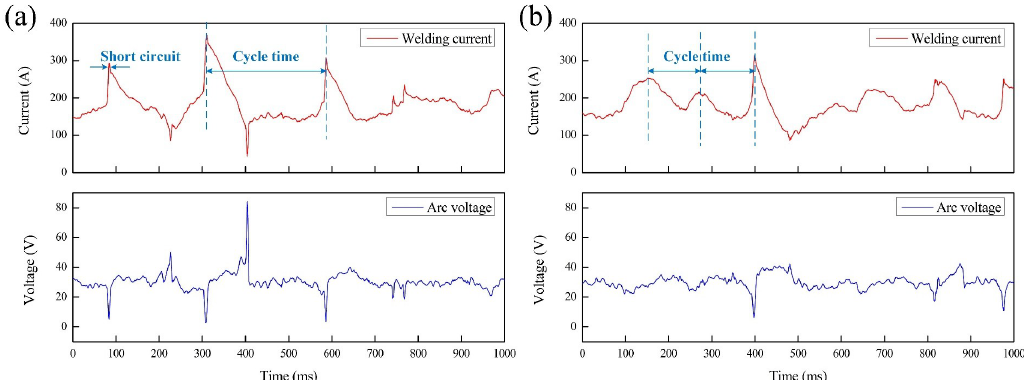
Figure 9. Typical electrical signal waveforms of welding process: ( a ) conventional wet flux-cored arc welding (FCAW), ( b ) ultrasonic-assisted flux-cored arc welding (UAFCAW).